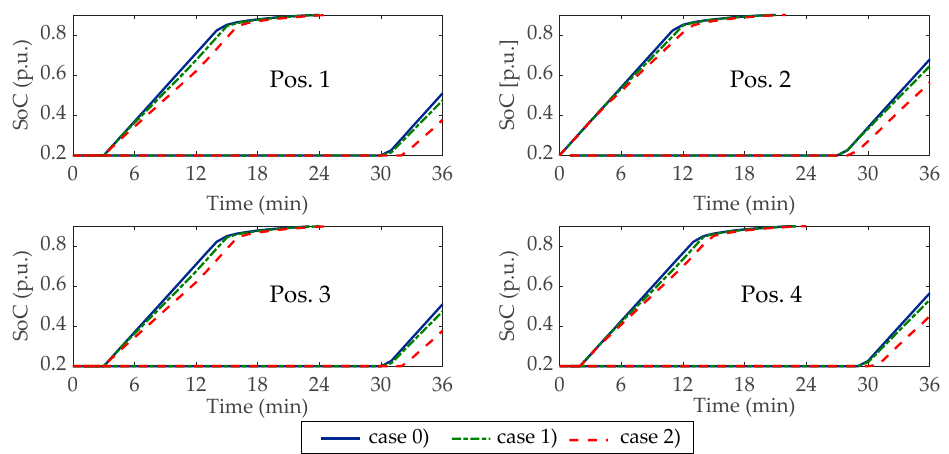
Figure 11. SoC profile of the PEVs plugged-in the UFC station at bus #12 (UFCS 3 ) in the three case studies.